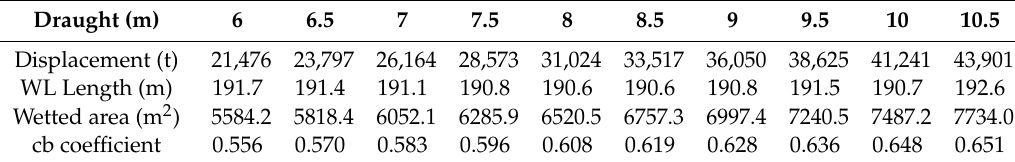
Table 5. Basic parameters of vessel form at design maximum draft value cb =